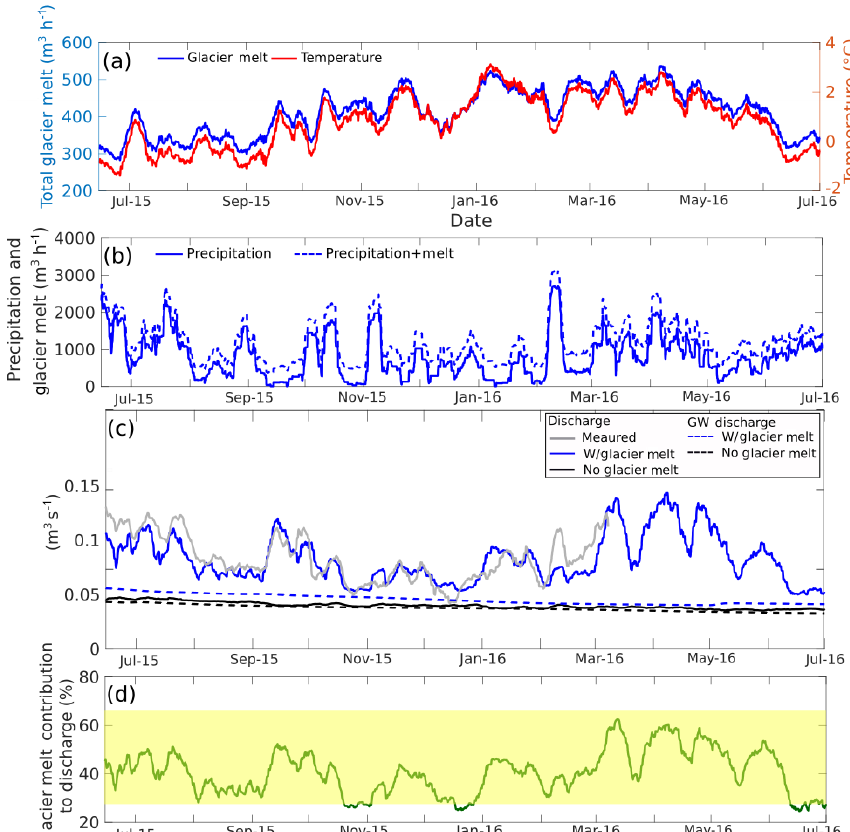
Figure 6. Time series of weekly moving average of (a) average air temperature over the ablation zone (glacier-covered areas below the ELA (5050ma.s.l.) and simulated glacier melt production; (b) precipitation (solid line) and precipitation+glacier melt production (dashed lines) (c) discharge at Gavilan Machay from observations (gray), calibrated simulations (blue solid), and simulations with no ice melt (black solid); groundwater contribution to discharge for calibrated (blue dashed) and for no-ice simulations (black dashed); and (d) simulated percent glacier melt contribution to discharge at Gavilan Machay. The shaded block shows the range of percent melt contributions estimated for five sampling periods over 2012–2017 from the mixing model; these estimates may include snowmelt in addition to glacier melt, but omit meltwater contributions through groundwater. Table 1. Soil hydraulic parameters calibrated for the three soil-type areas compared against the range predicted using the pedotransfer func- tion with measured páramo soil textures in Ecuador (Podwojewski et al., 2002; Minaya, 2016). Parameters include hydraulic conductivities for vertical infiltration (KINFV), vertical saturated zone flow (KSATV), and horizontal saturated zone flow (KSATH); porosity; residual soil moisture ( θ res ); and shape parameters ( α and β ) for the van Genuchten moisture retention curve: θ = θ res + porosity × with water content θ and pressure head ψ .